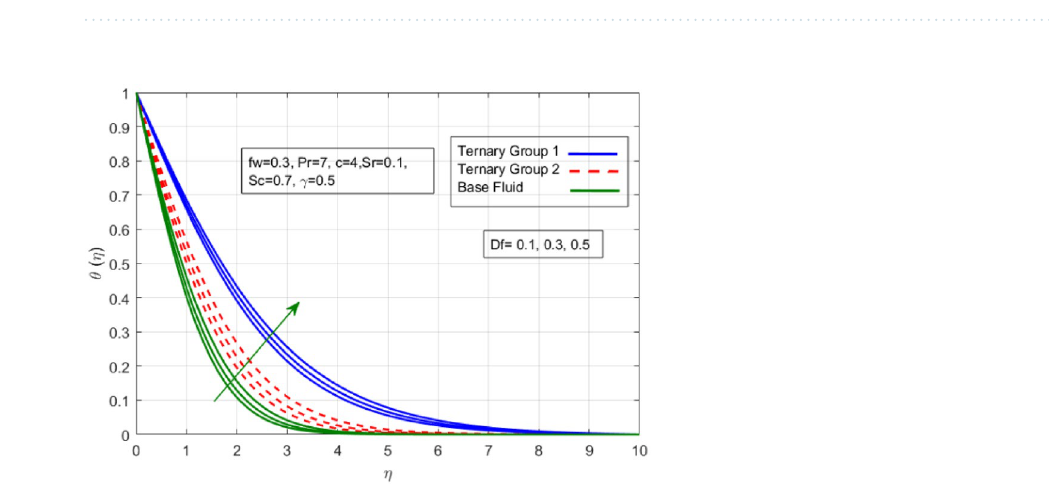
Figure 10. Variation in temperature against Soret number (Sr).